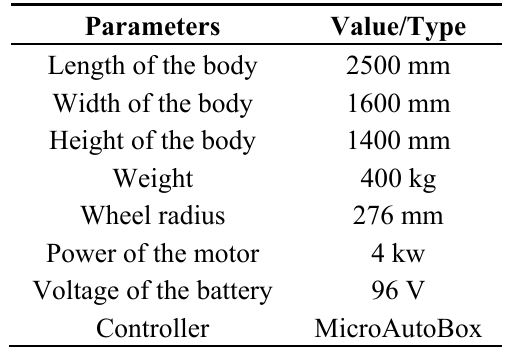
Figure 12. Test vehicle. ( a ) Photo of the vehicle; ( b ) Experimental system configuration; ( c ) The controller design process using MicroAutoBox; ( d ) The ControlDesk panel. Table 2. Specifications of the experimental